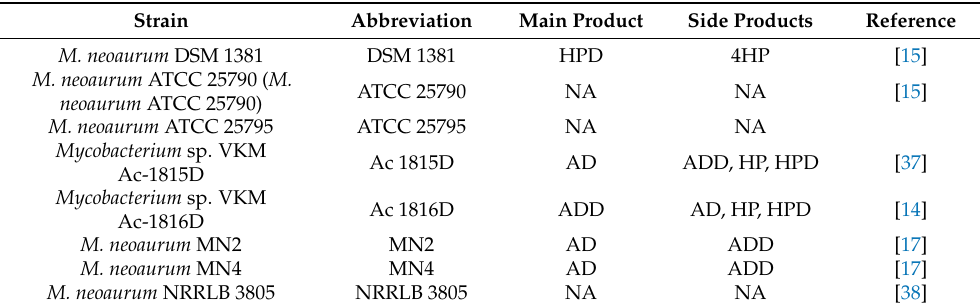
Table 3. Information on the strains used for comparative